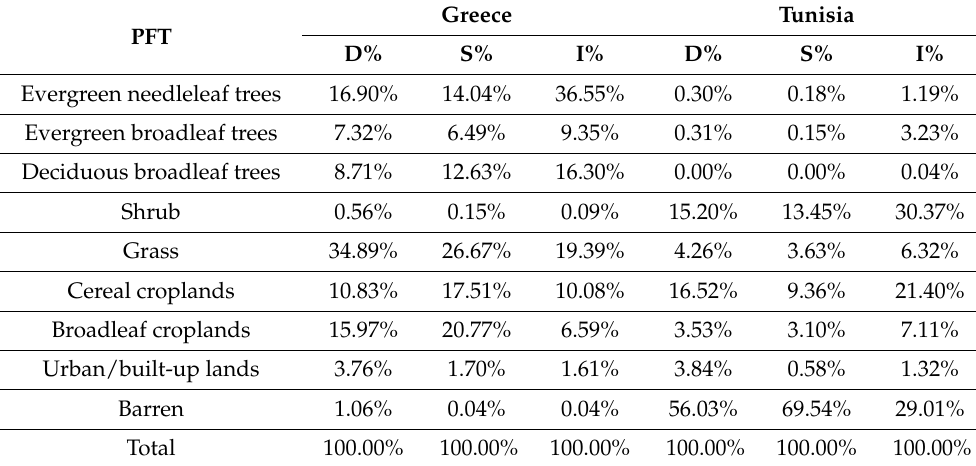
Table 9. Analysis of PFT contribution per land degradation status in Greece and Tunisia for the reporting period (D: Degraded, S: Stable, I: Improved). Greece Tunisia PFT D% S% I% D% S% I% Evergreen needleleaf trees 16.90% 14.04%